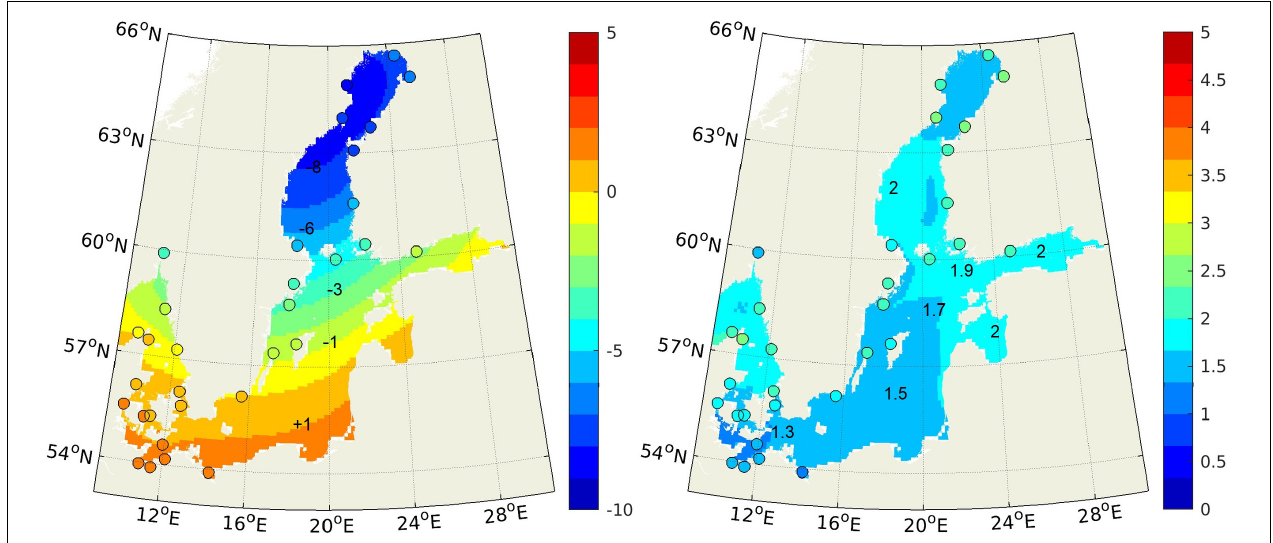
FIGURE 9 | Linear sea level trends (mm/yr) derived from SRM and from tide gauges, 1915–2014. Left: relative to land; right: absolute values. Note that only tide gauges with adequate record length have been included. Also note that the trends in tide gauges may exceed (up to 1 mm/yr) the trends in the offshore area.